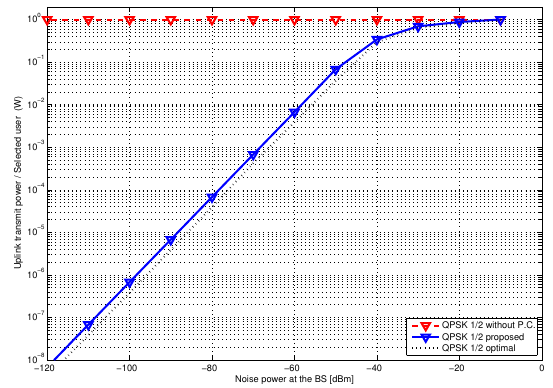
Figure 13. Transmit power of QPSK-1/2 versus noise